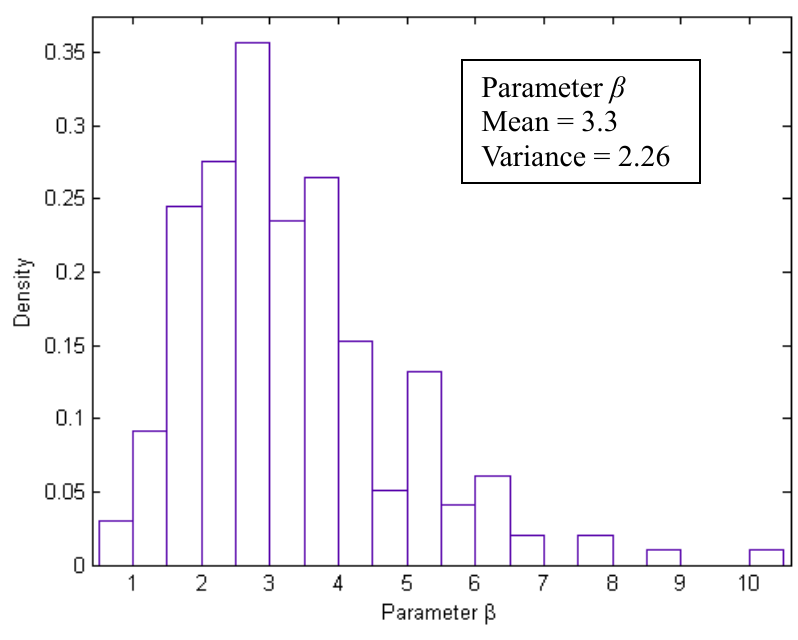
Figure 3. The probability density function of the parameter β .